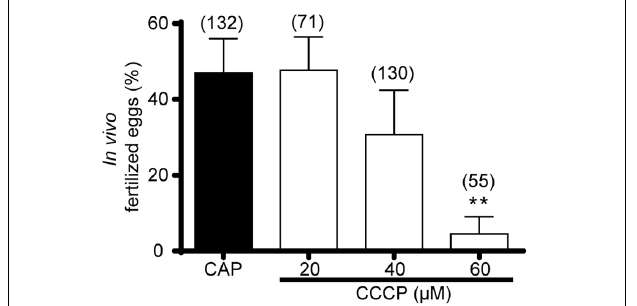
FIGURE 6 | Relevance of mitochondrial activity on mouse sperm in vivo fertilizing ability. Epididymal sperm in a non-capacitating concentration were incubated in the capacitation medium containing CCCP (20–60 µ M) or DMSO (capacitated sperm, CAP), and used to inseminate superovulated females. After 15 h, COCs were collected from the ampulla , and incubated in KSOM medium, scoring the percentage of 2-cell embryos 24 h later. Results are expressed as mean ± SEM. At least 4 independent experiments were performed in which one or more females per treatment were included. In brackets is indicated the total number of analyzed eggs per treatment. ** p <